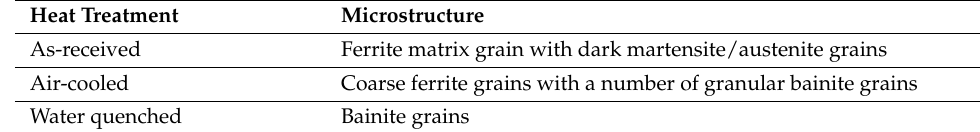
Table 7. Different microstructures of the exposed X70 samples. Data from